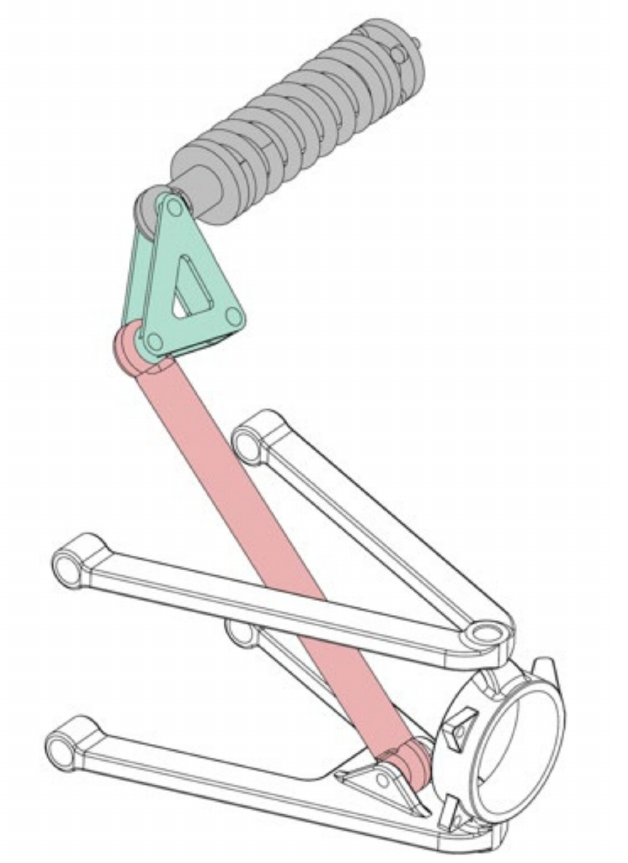
Figure 8. Double wishbone suspension with pushrod (red), rocker (green) and spring-damper unit